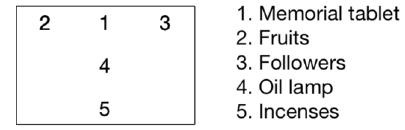
Figure 5. Ritual arrangement of the portable memorial altar of the dead ( Khai Vong ).